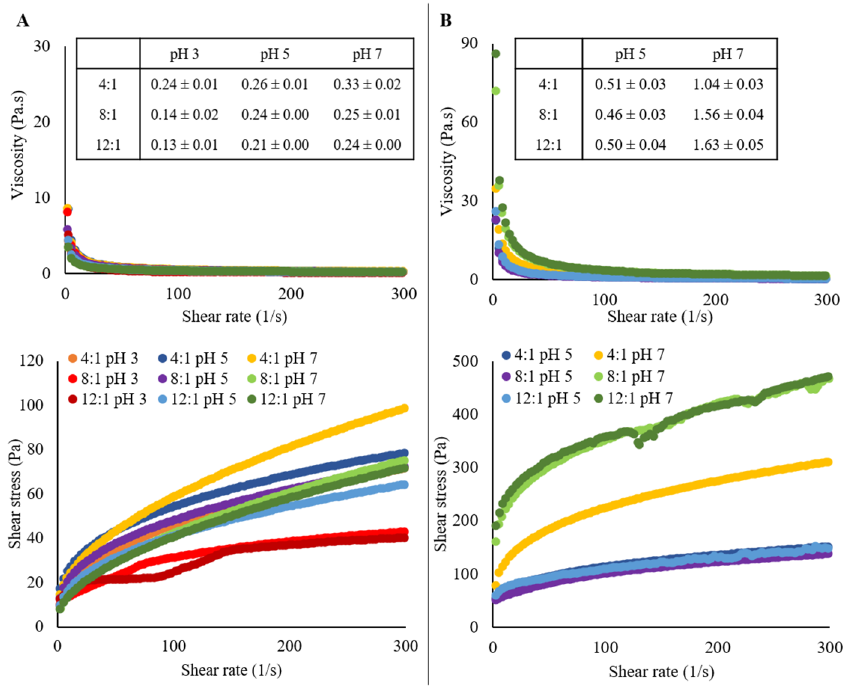
Figure 5. Steady-state rheology (Shear stress and viscosity) of the emulsions ( A ) and HIPEs ( B ). Apparent viscosity (Pa.s) at a shear rate of 300 1/s is presented in the tables.